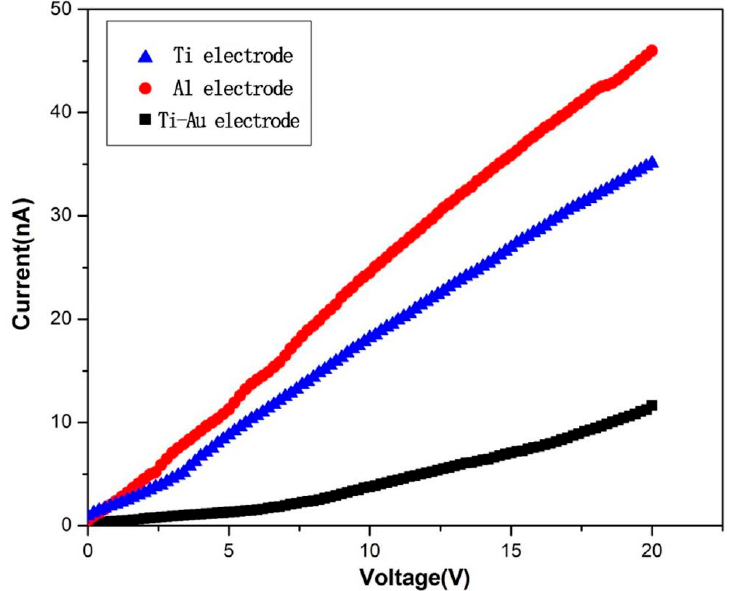
Figure 8. The I–V curves of the Ti-Au/CdZnTe sample annealed at 423 K for different times. Table 5. The I–V curves fitting results of Ti-Au/CdZnTe annealed at 423 K for different times.